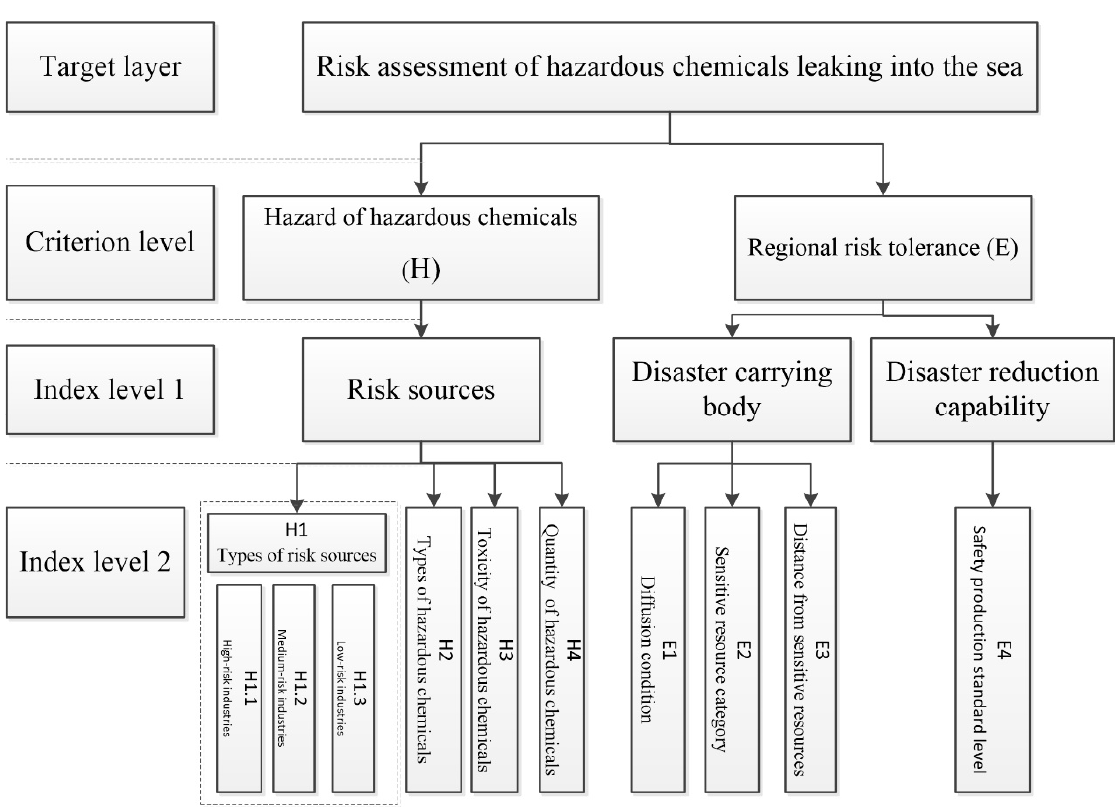
Figure 1. Risk-assessment indicators for hazardous chemicals leaking into the sea.